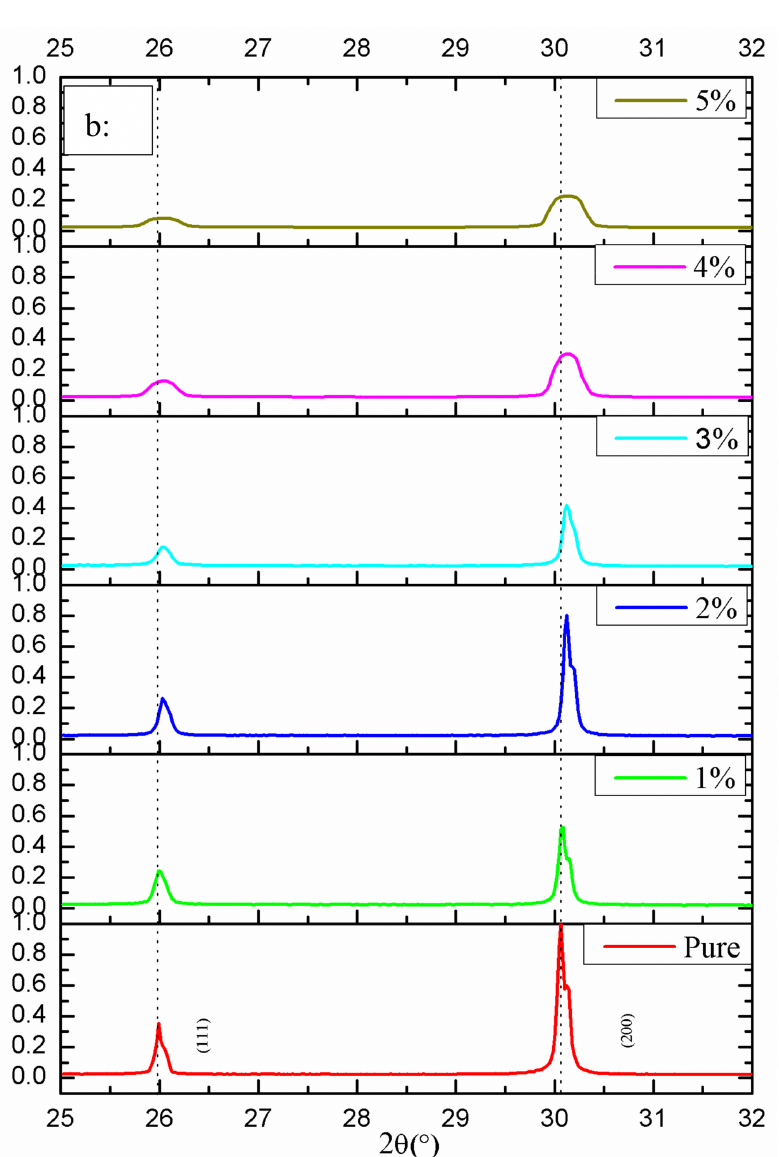
Figure 1. ( a ) X-ray di ff raction (XRD) patterns of pure and Cr-doped lead sulfide (PbS) films; ( b ) shifts in the 2 θ value of Cr-doped PbS thin films. Table 1. Structural parameters of pure and Cr-doped lead sulfide (PbS) thin films obtained by X-ray di ff raction (XRD) spectra. FWHM—full-width at half-maximum. Cr Content